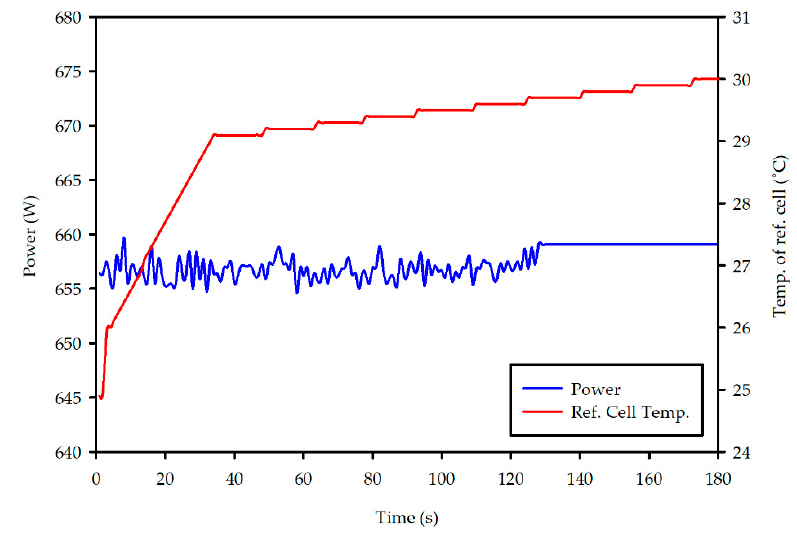
Figure 10. Energy generated by the solar simulator.